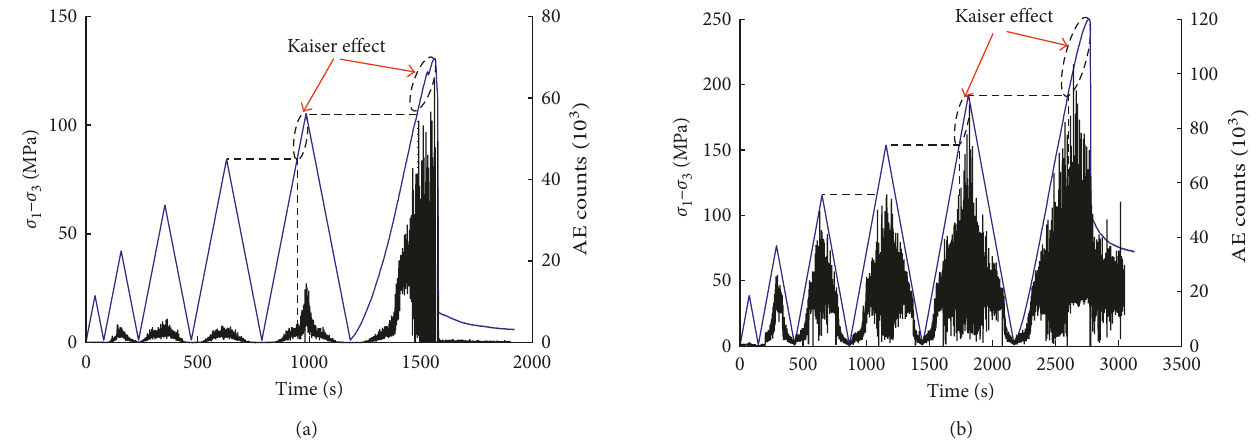
Figure 1: Time history curves of stress and AE counts of samples under cyclic loading. (a) σ